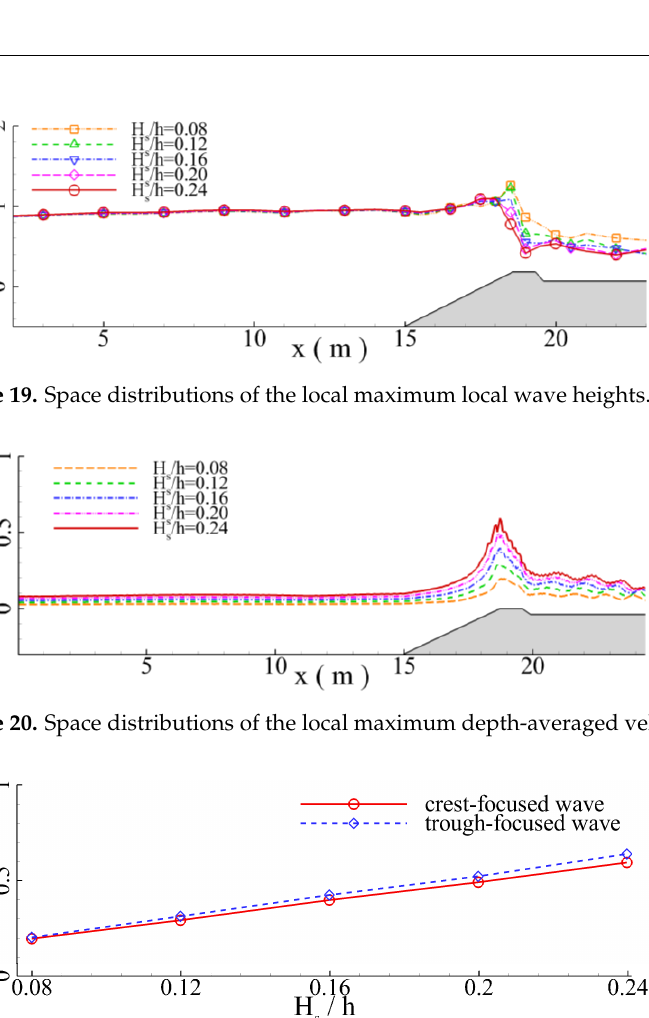
Figure 21. Maximum depth-averaged velocity at the reef crest versus the relative significant wave height.